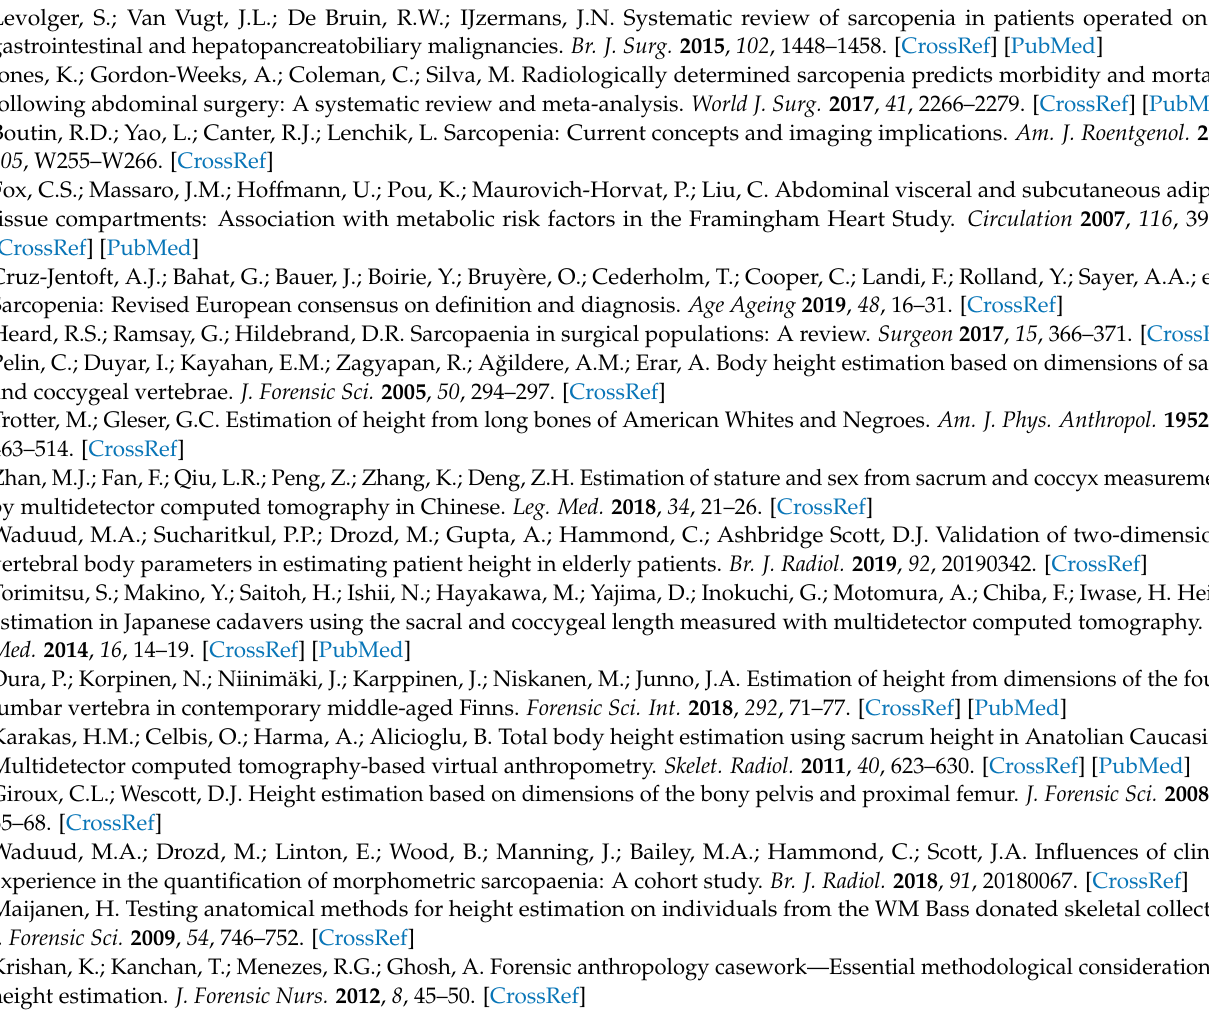
Table A1. Definitions of vertebral parameters used in height estimation formulae. VBA Cross-sectional area of the vertebral body just inferior to the superior endplate Maximum linear distance between two points on the outer cortex of the vertebral LVBD body in the lateral (coronal) dimension on axial imaging just inferior to the superior endplate Maximum linear distance between two points on the outer cortex of the vertebral APVBD body in the antero-posterior (sagittal) dimension on axial imaging just inferior to the superior endplate Linear distance between the most anterosuperior point of the first sacral vertebra ASL (S1) and the most anteroinferior point of the fifth sacral vertebra (S5) Linear distance between the most posterosuperior point of S1 and the most PSL anteroinferior point of the S5 vertebral body Linear distance between the most anterosuperior point of S1 and the most ASCL anteroinferior point of the last coccygeal vertebral body Linear distance between the most posterosuperior point of S1 and the most PSCL anteroinferior point of the last coccygeal vertebral